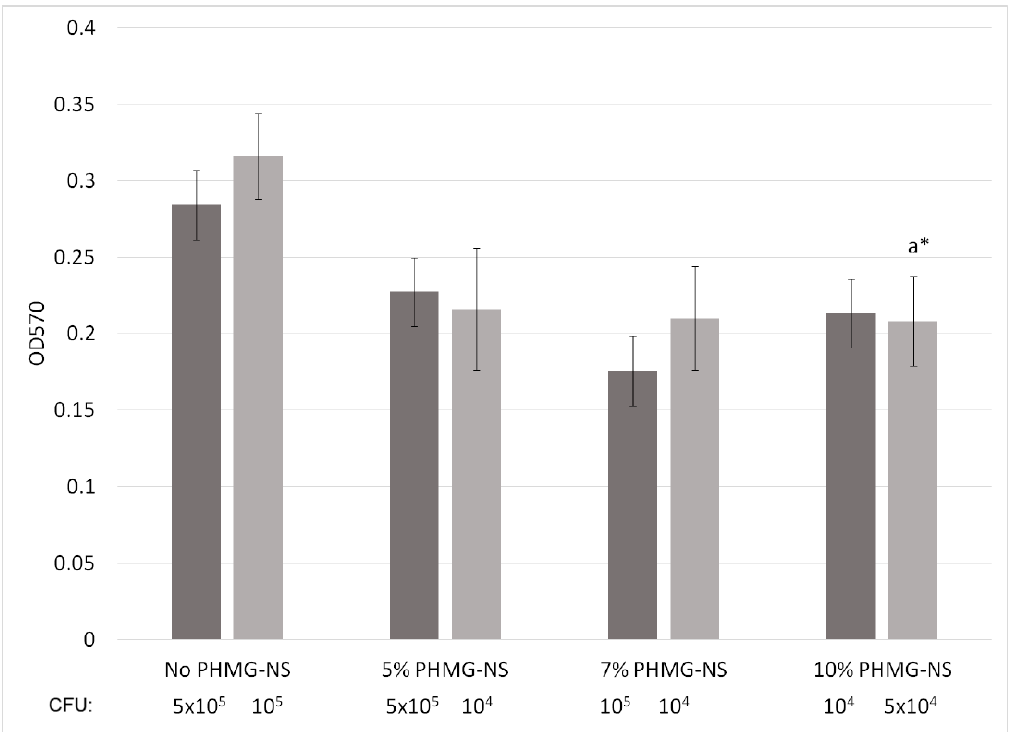
Figure 5. The level of planktonic cell biomass (overbiofilm layer indicated by the optical density at 570 nm (OD570)) of K12 (dark grey) and ATCC 25923 (light grey) in the presence of PA-11 films containing 5%, 7% and 10% of PHMG-NS following 72 h of incubation, correlated with the corresponding CFU counts. a: statistical significance compared to control (No PHMG-NS); * p < 0.05.